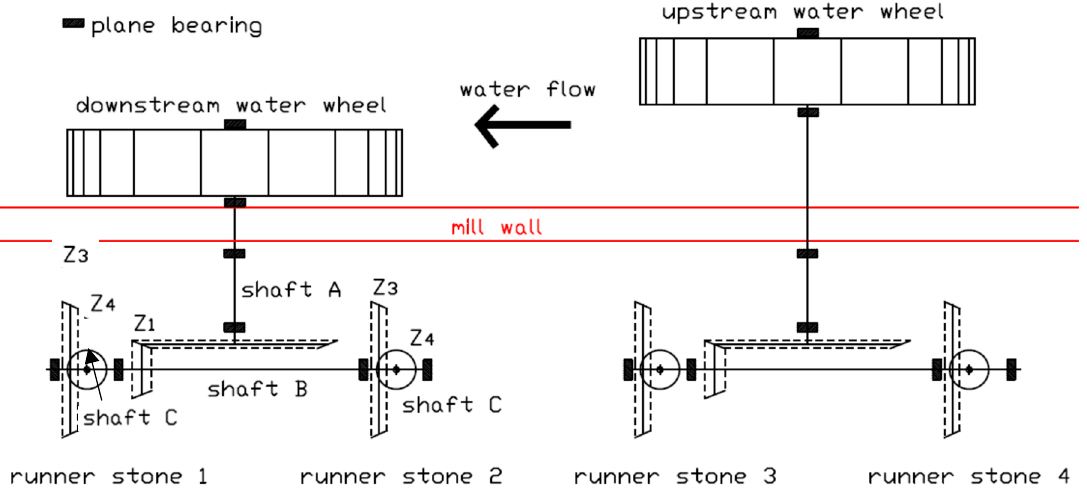
Figure 7. Plan view scheme of the Riviera mill power transmission.